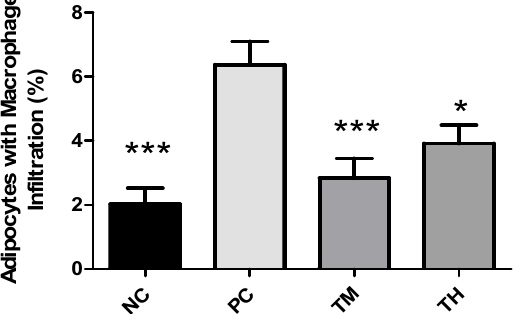
Figure 7. Percentage of adipocytes with macrophage infiltration in adipose tissue of mice with LPS-induced chronic inflammation. Results are expressed as means ± SEM. Differences in means were considered statistically significant for * p < 0.05, or *** p < 0.001 relative to PC.